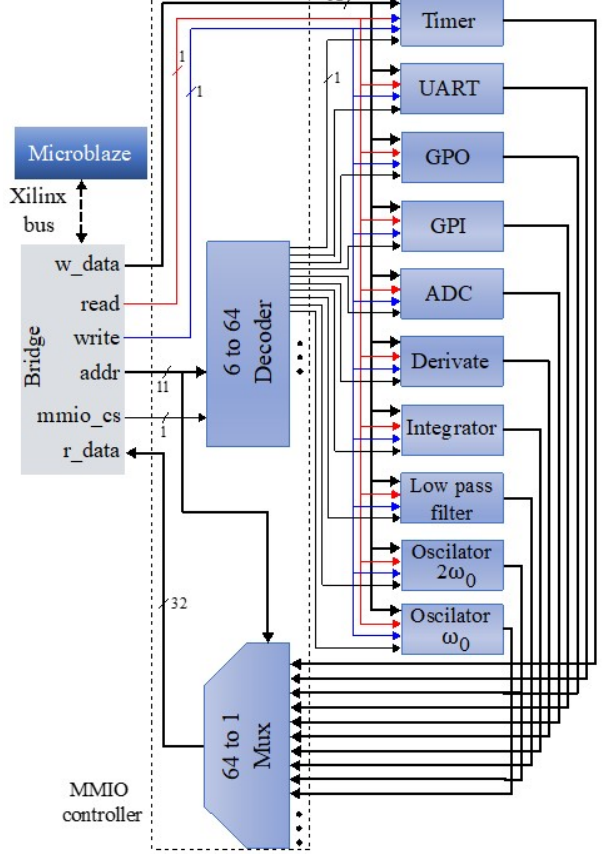
Figure 4. The FPGA-based implementation architecture of the interrogation